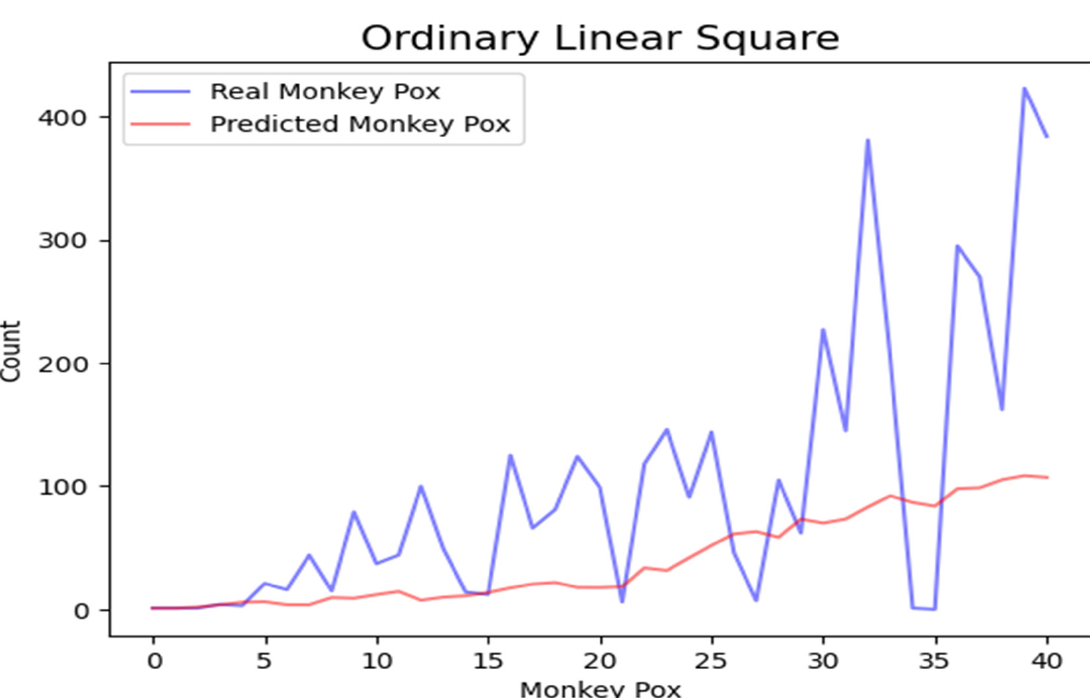
Figure 14. Time Series of Ordinary Least Square.